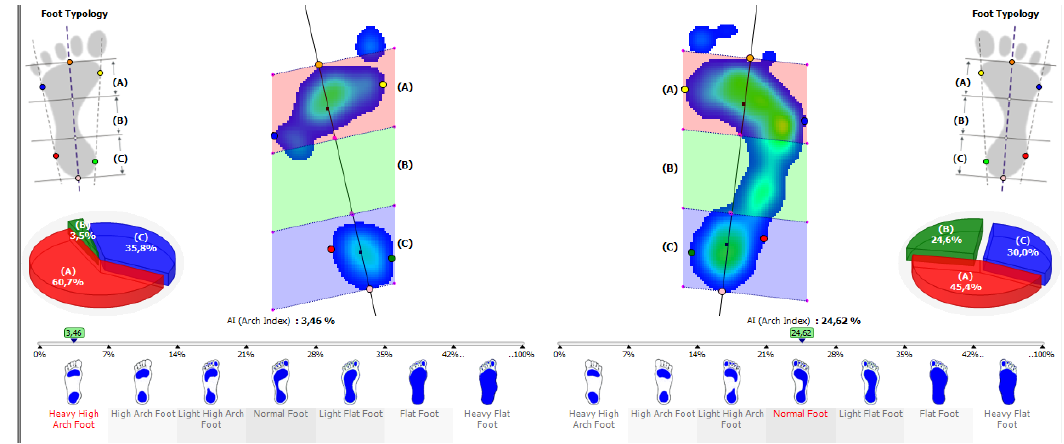
Figure 2. An example image with the results of pressure distribution on the sole of the foot from the Biomech Studio software.